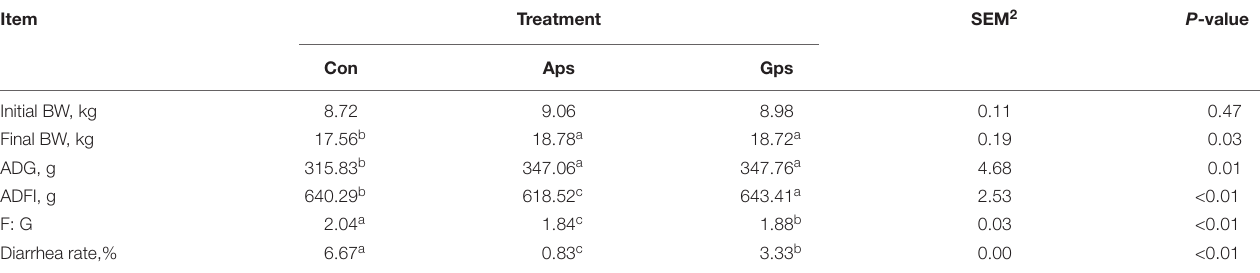
TABLE 2 | Effects of the APS and GPS on growth performance of the weaned piglets 1 . Item